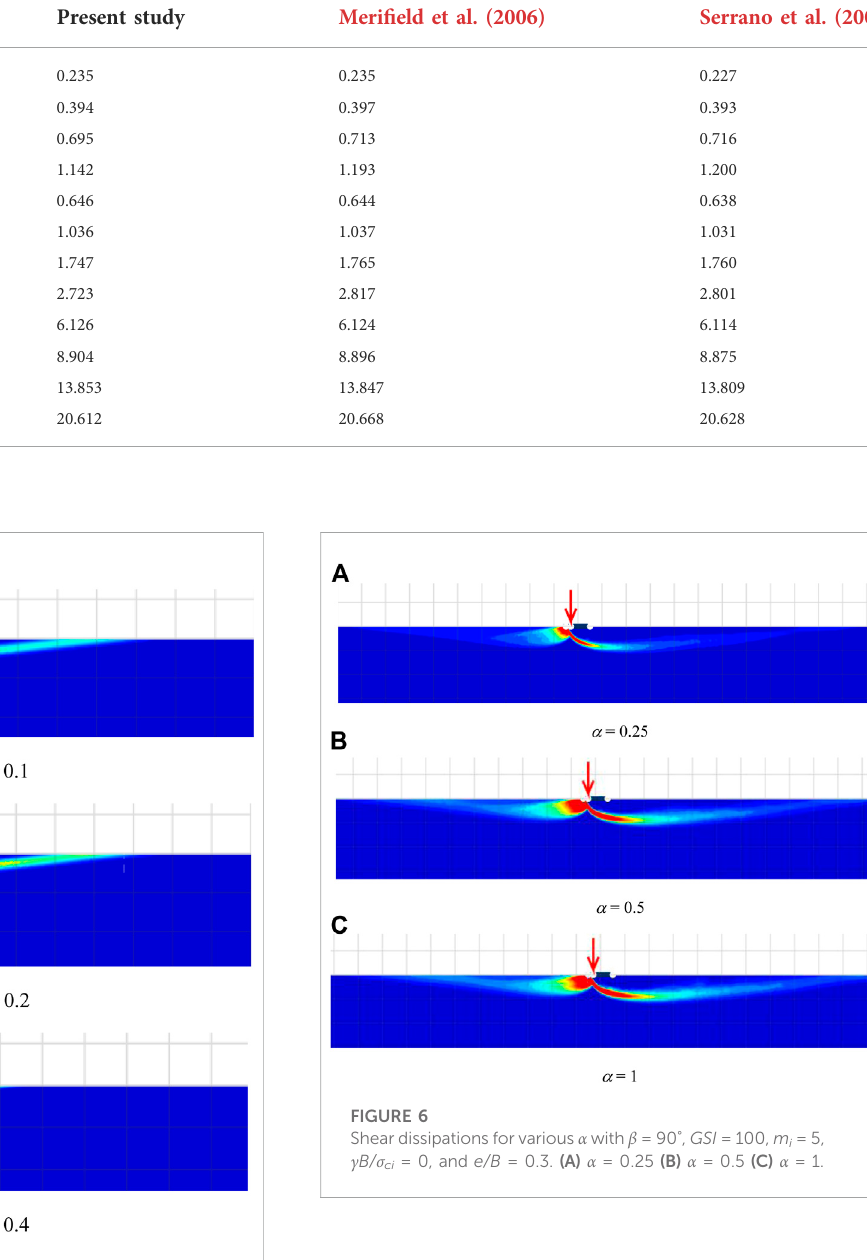
FIGURE 5 Sheardissipationsforvarious e/B with. β =45 ° , GSI =100, m i = 5, γ B/ σ ci = 0, and α = 1. (A) e/B = 0.1 (B) e/B = 0.2 (C) e/B = 0.4.